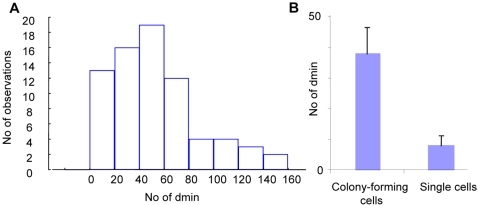
DM copy-number distributions in bulk populations.A. The frequency distribution of DM copy-numbers in near-diploid metaphase cells in LA-N-5 is skewed and differs from a normal distribution. B. Median DM-copy numbers in colony-forming compared to non-colony forming CHP-212 cells; error bars denote 25th and 75th percentiles.